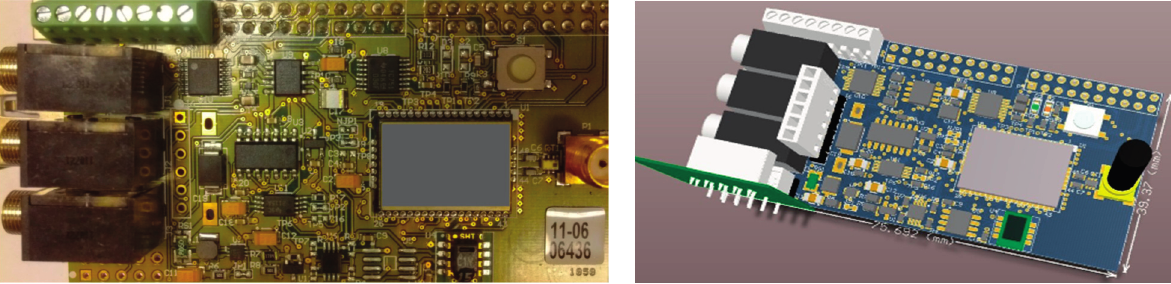
Figure 14. Prototype board of iLive node. iLive is equipped with the ATmega1281 microcontroller as well as 11 sensors (one temperature sensor, one light sensor, one air sensor, one humidity sensor, three soil moisture decagon sensors [26] and four soil moisture watermark sensors [27]).